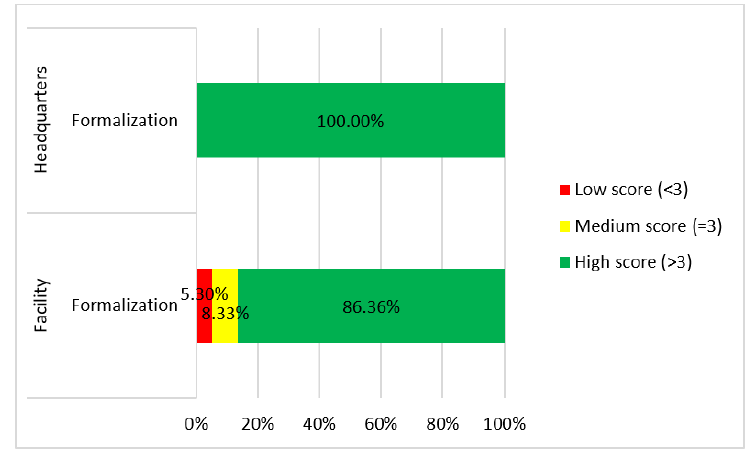
Figure 11. Categorized BARS percentages for attention to safety, by location.